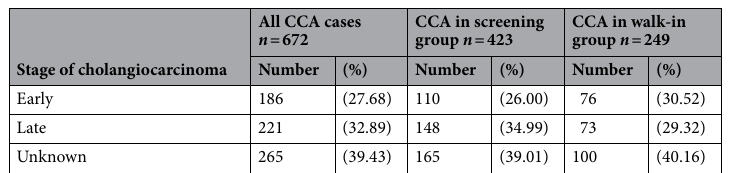
Table 2. Percent distribution of cholangiocarcinoma according to staging and cohort group. CCA cholangiocarcinoma, n number of sample, Unknown—Can not identify stage of CCA.